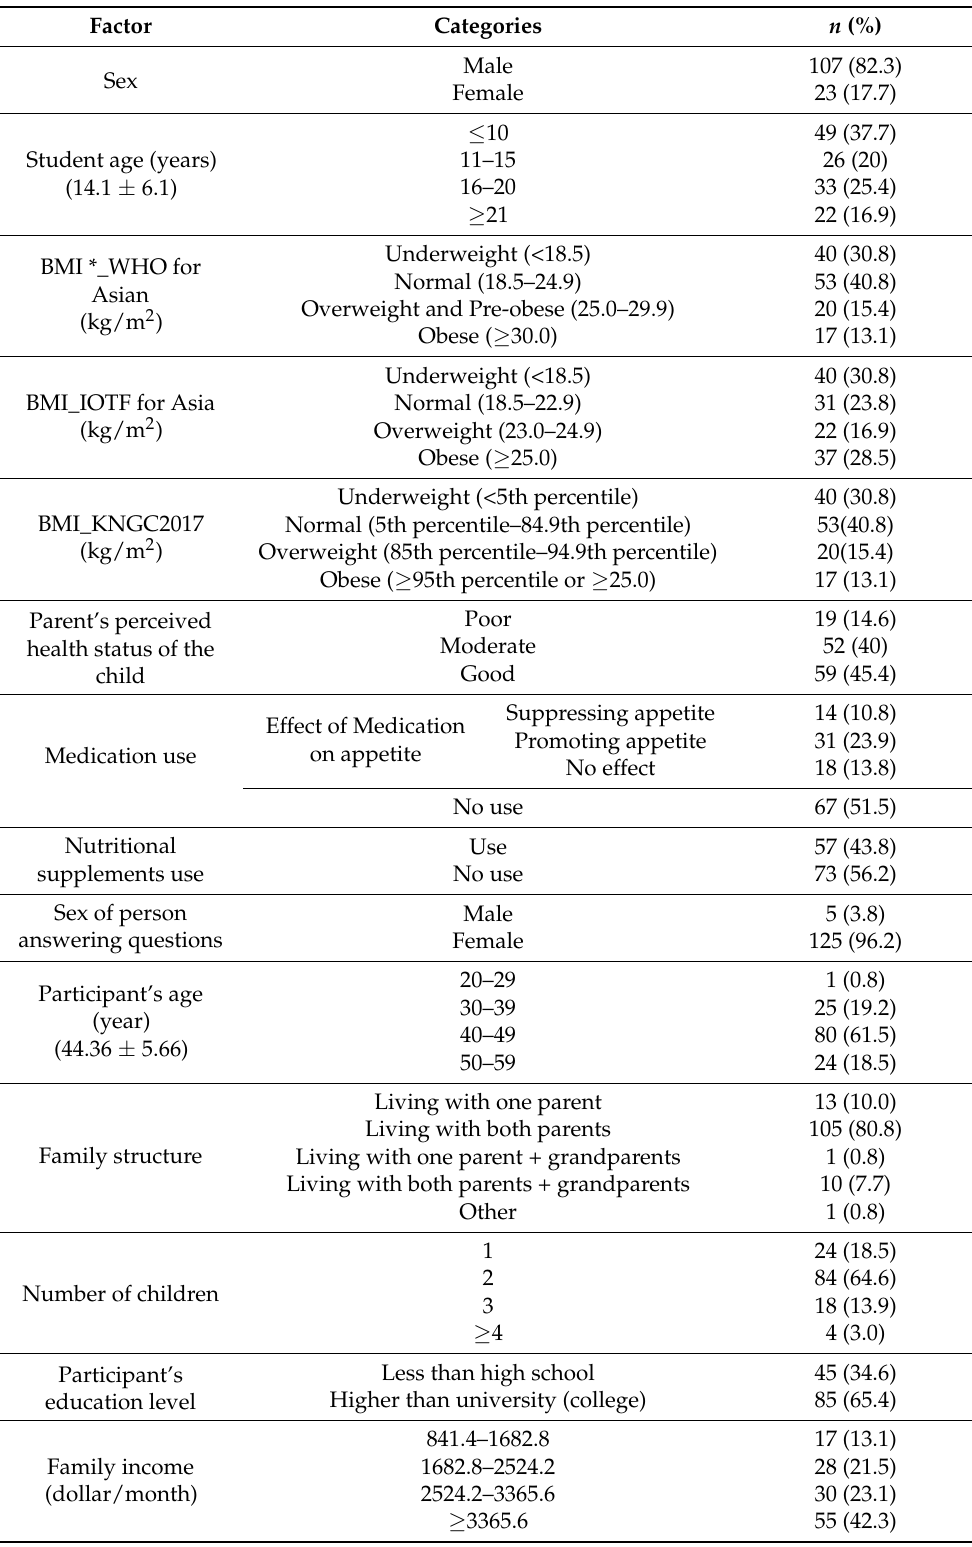
Table 1. Demographic characteristics of the participants ( n =